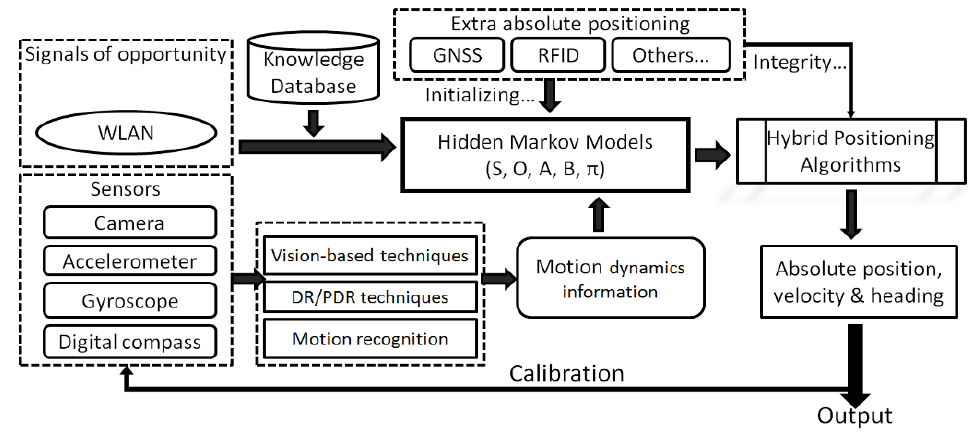
Figure 4. The general high-level architecture of the HMM solution that fuses the measurements of the sensors and WLAN to estimate the absolute